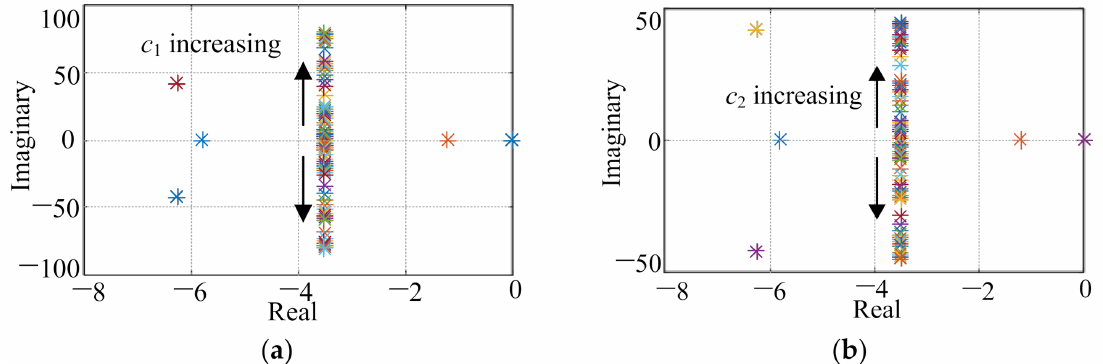
Figure 5. System dominant root locus at ( a ) c 1 ∈ [1, 10,000]; ( b ) c 2 ∈ [1,